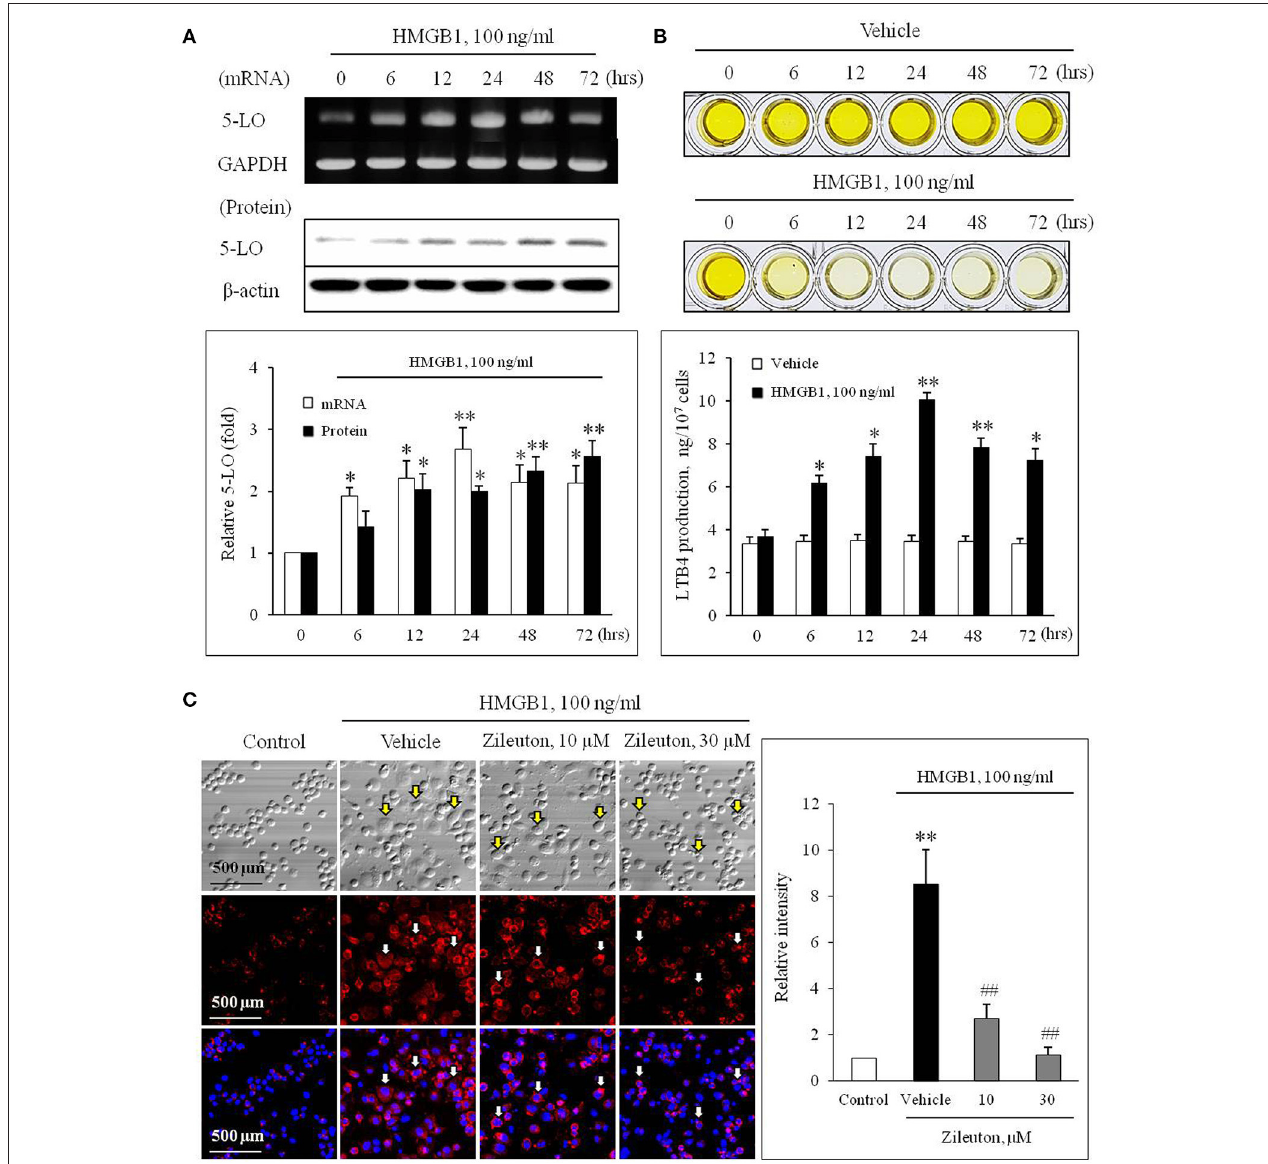
FIGURE 1 | Role of 5-LO in monocytes on monocyte-to-macrophage differentiation (MMD) induced by HMGB1. (A) Time-courses of the expressions of 5-LO mRNA and protein in BMDCs stimulated with HMGB1 (100ng/ml) were determined using RT-PCR and Western blot, respectively. Bottom: Blot densities were quantified and presented as the means ± SEMs of 6–7 independent experiments. * P < 0.05; ** P < 0.01 vs. corresponding value at 0h. (B) Time-course of LTB4 production in vehicle- or HMGB1 (100ng/ml)-stimulated BMDCs as determined by ELISA. Bottom: Color signals were quantified, and data were presented as the means ± SEMs of 6–7 independent experiments. * P < 0.05; ** P < 0.01 vs. value at 0h. (C) Representative immunocytochemical images of BMDCs stimulated with HMGB1. BMDCs were pre-treated with Zileuton at 10 or 30 µ M for 1h, and then stimulated with HMGB1 (100ng/ml) for 10 days. Cells were stained with anti-CD11b/Mac-1 (red) and DAPI (blue), and then morphological changes and CD11b/Mac-1 expressions were photographed under a phase contrast microscope. Arrows indicate cells with a macrophage-like morphology. Right: Images were analyzed using Image J, and data were presented as the means ± SEMs of 3–4 independent experiments. ** P < 0.01 vs. control, ## P < 0.01 vs. vehicle.